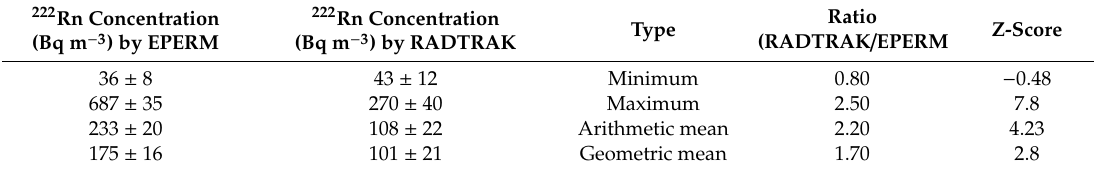
Table 2. Ratio (RADTRAK / EPERM) activity concentrations of indoor 222 Rn and Z-score test. 222 Rn Concentration